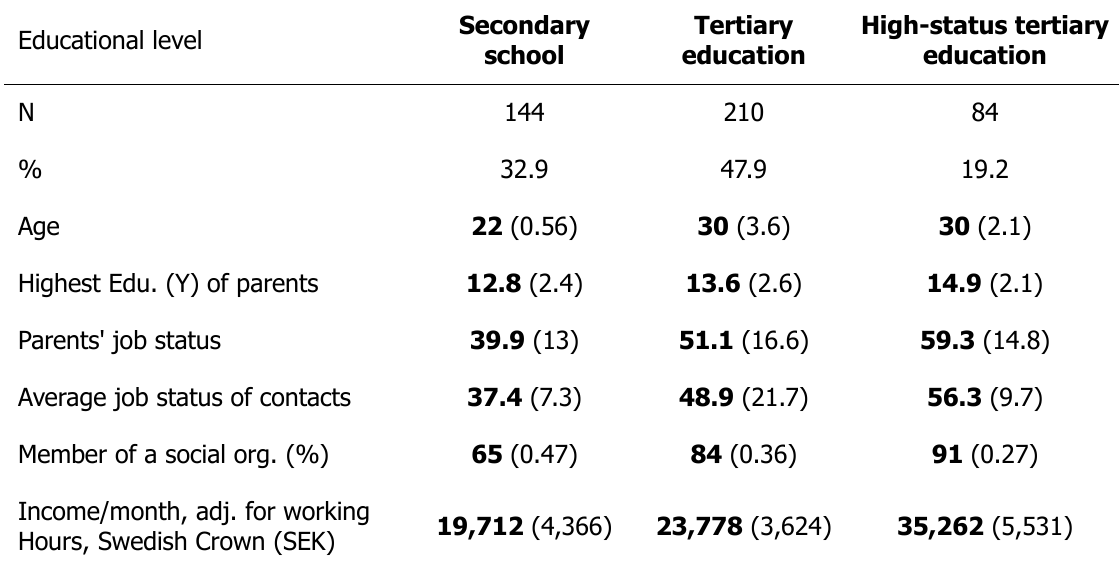
Table 1. Summary of sample characteristics for three educational levels, means (S.E.) or